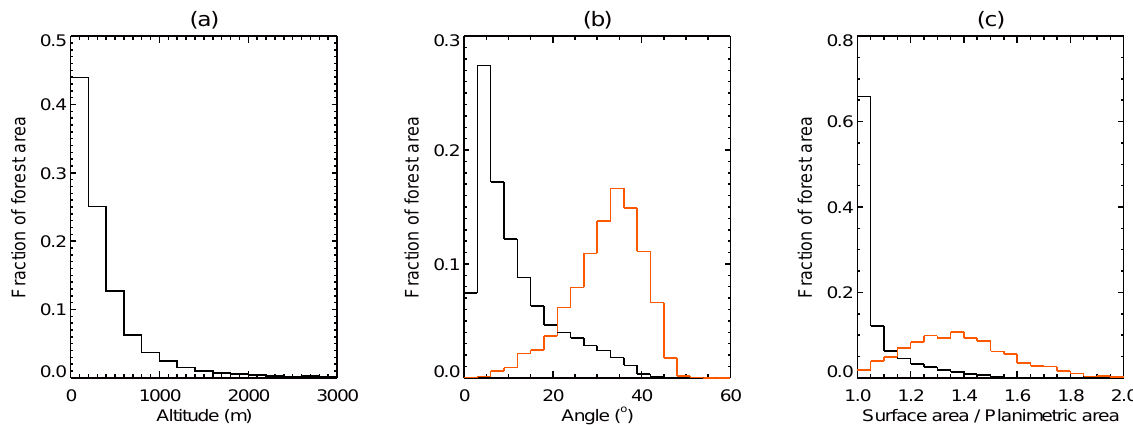
Figure 4. Distribution of the planimetric area of global tropical forests as a function of (a) elevation, (b) slope angle. (c) Ratio of surface area to planimetric area (lowland (elevation < 1000m) tropical forest: black; tropical montane forest (elevation ≥ 1000m): red).